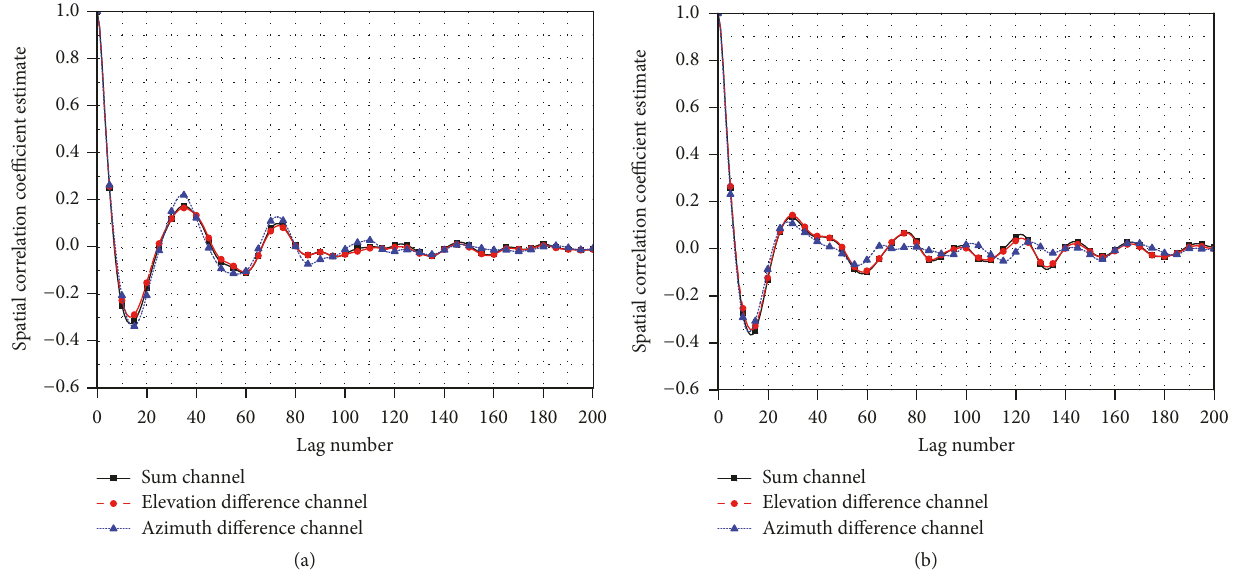
Figure 16: The averages of the spatial correlations of the texture for DS1 and DS2: (a) DS1. (b)